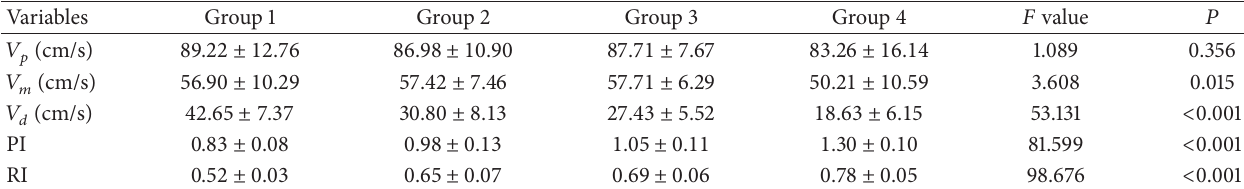
Table 3 indicates comparison of age, sex, educational years, etiology, Child-Pugh grading, Child-Pugh scores, ammonia, Cr, TBil, ALB, PT, NCT-A, and DST between groups A and B before treatment. Group A is the control group; group B is the treated group. Continuous data were compared using 𝑡 -test and categorical data were compared by a chi-square test. 𝑃 < 0.05 means significant differences in an index between two groups. Table 4: Comparison of TCD before